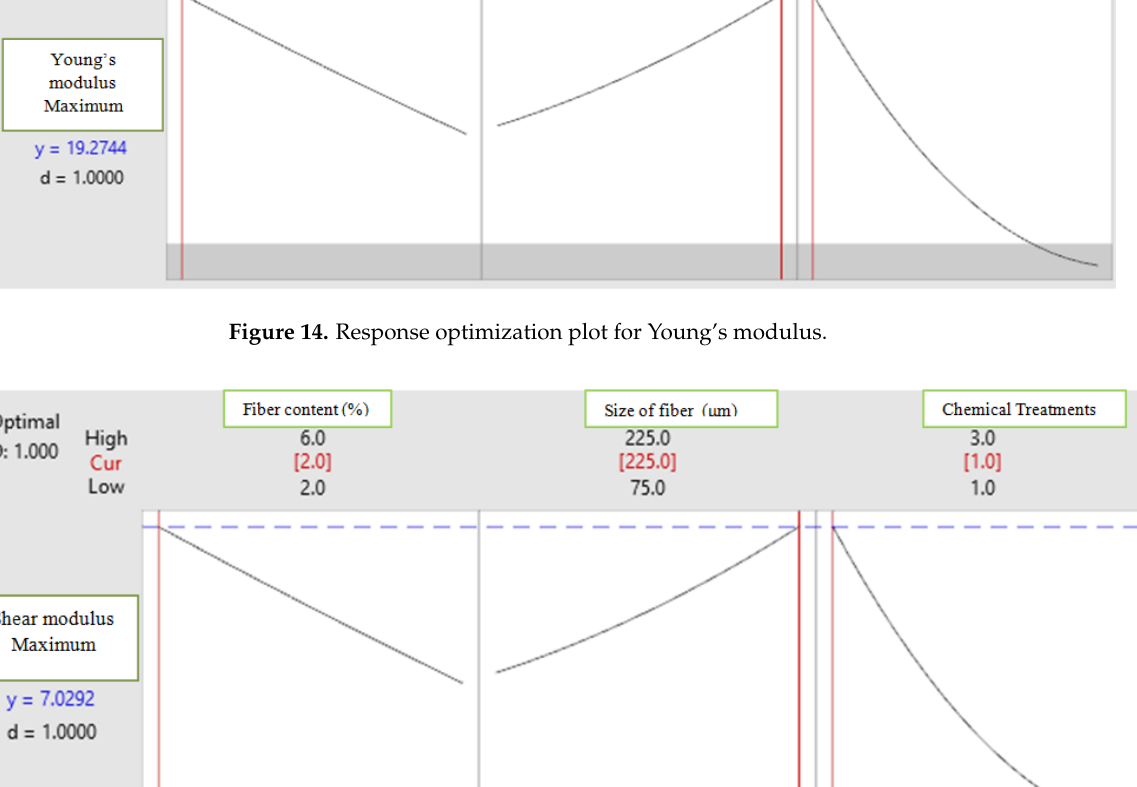
Table 7. Optimized combination of